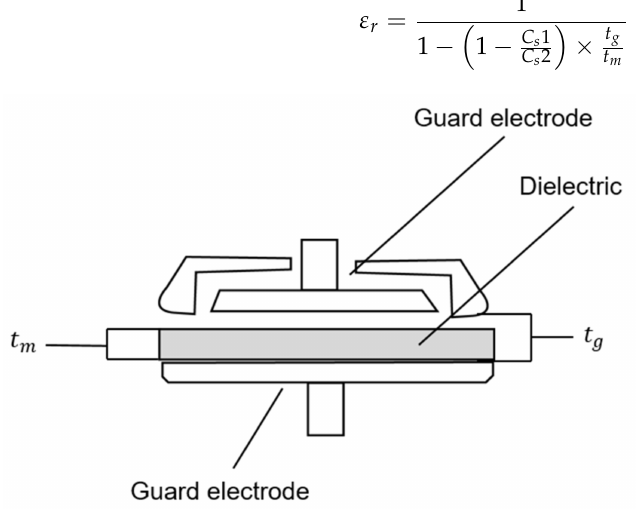
Figure 6. Noncontacting electrode